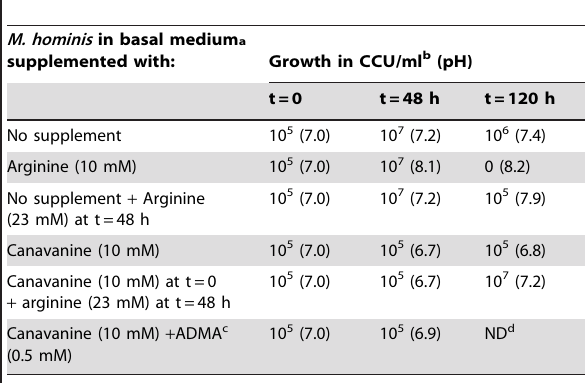
Table 3. Growth of M. hominis PG21 in the presence of arginine and arginine